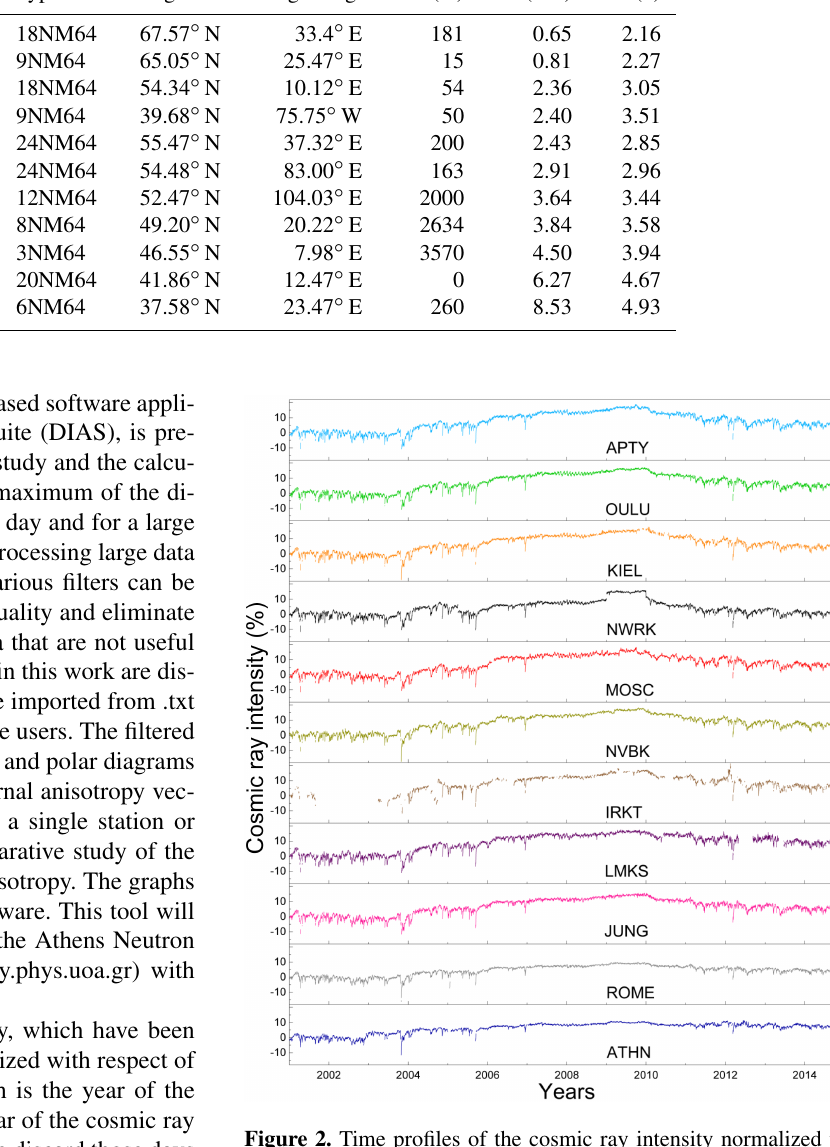
Table 1. Characteristics of the NM stations used in this work. NMs Type Geogr. lat. Geogr. long.